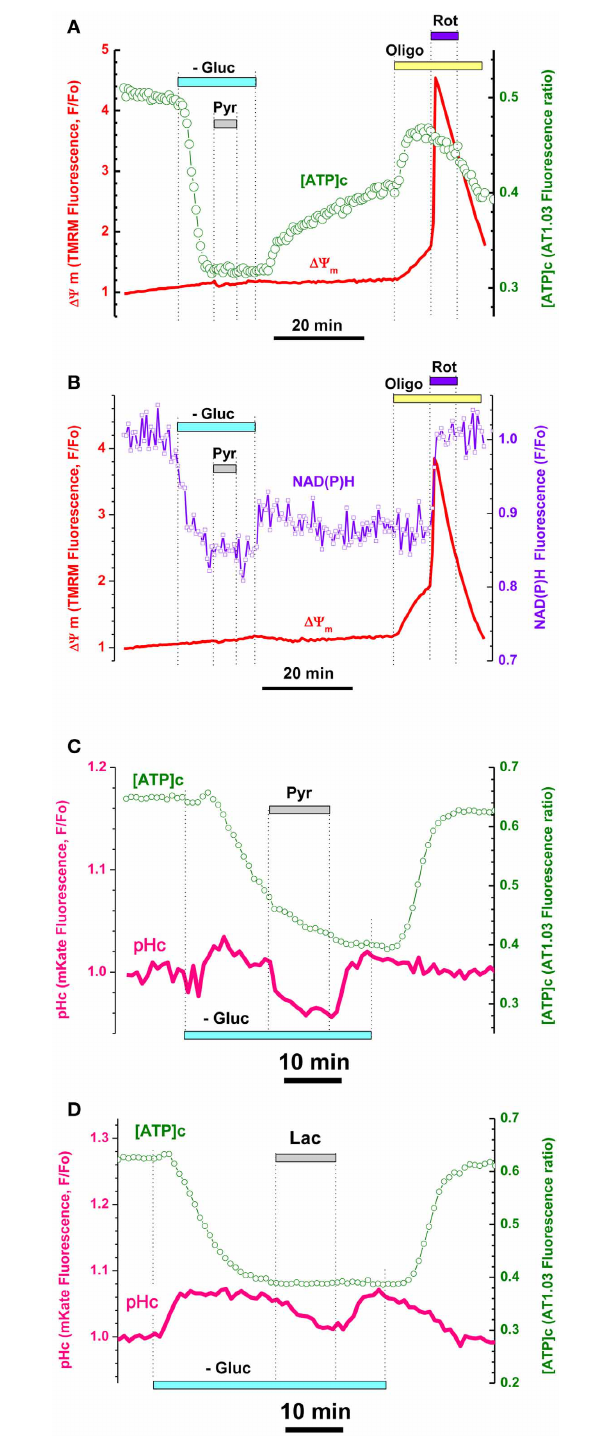
FIGURE 3 | Pyruvate and lactate failed to increase [ATP]c, (cid:2)(cid:3) m, and NAD(P)H despite their penetration into cytosol of hippocampal embryonic neurons. (A) Simultaneous measurement of [ATP]c (green trace, right axis) and (cid:2)(cid:3) m (red trace, left axis) in neuron expressing AT1.03 and loaded with TMRM. Gluc-free buffer application is indicated with